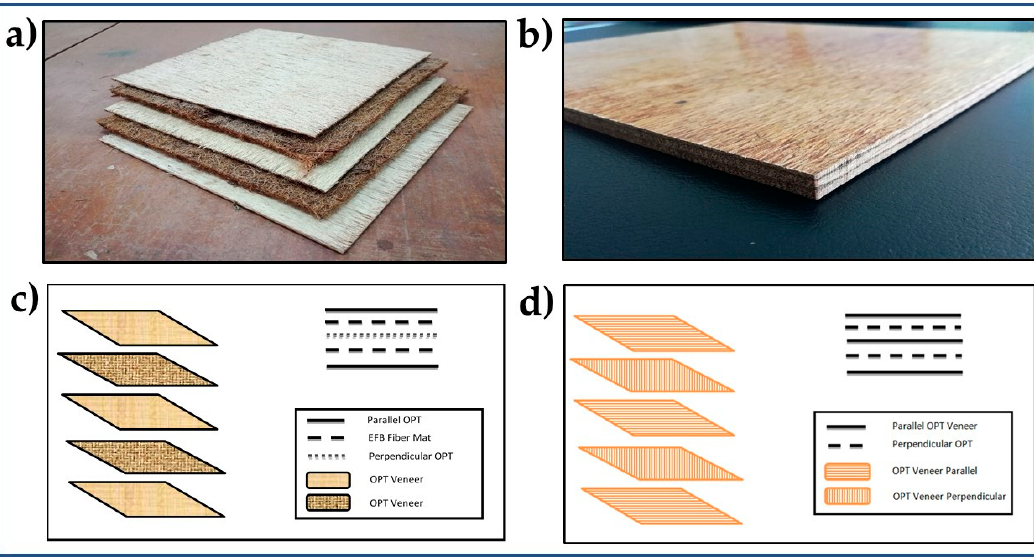
Figure 1. ( a ) Layering pattern of five plywood hybrid, ( b ) hybrid plywood composite, ( c ) schematic Figure 1. a ) Layering pattern of five plywood hybrid, b ) hybrid plywood composite, c ) schematic arrangement of hybrid plywood, ( d ) schematic arrangement of OPT veneer arrangement of hybrid plywood, d ) schematic arrangement of OPT veneer plywood.